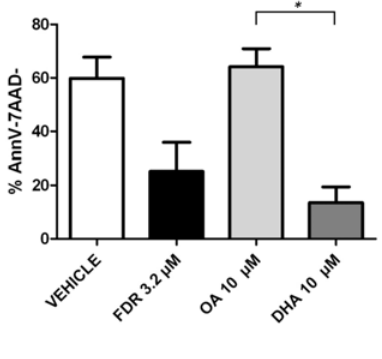
Figure 2. Effects of OA 10 µM and DHA 10 µM on apoptosis of primary CLL cells (10 samples). CLL cells viability was assessed by Annexin V-FITC/7-AAD immunostaining after exposure to OA and DHA 10 µM for 24 hours. Fludarabine 3.2 µM as positive control for apoptosis of primary CLL cells. Viable cells assessed by % of both Annexine V and 7-AAD nega- tive are shown as mean ± standard error of mean. Statistical comparisons were per- formed using the Mann-Whitney test.*, P=0.0003; AnnV-7AAD-, Annexine V- negative and 7AAD-negative; FDR, flu- darabine; OA, oleic acid; DHA, docosa- hexaenoic acid.